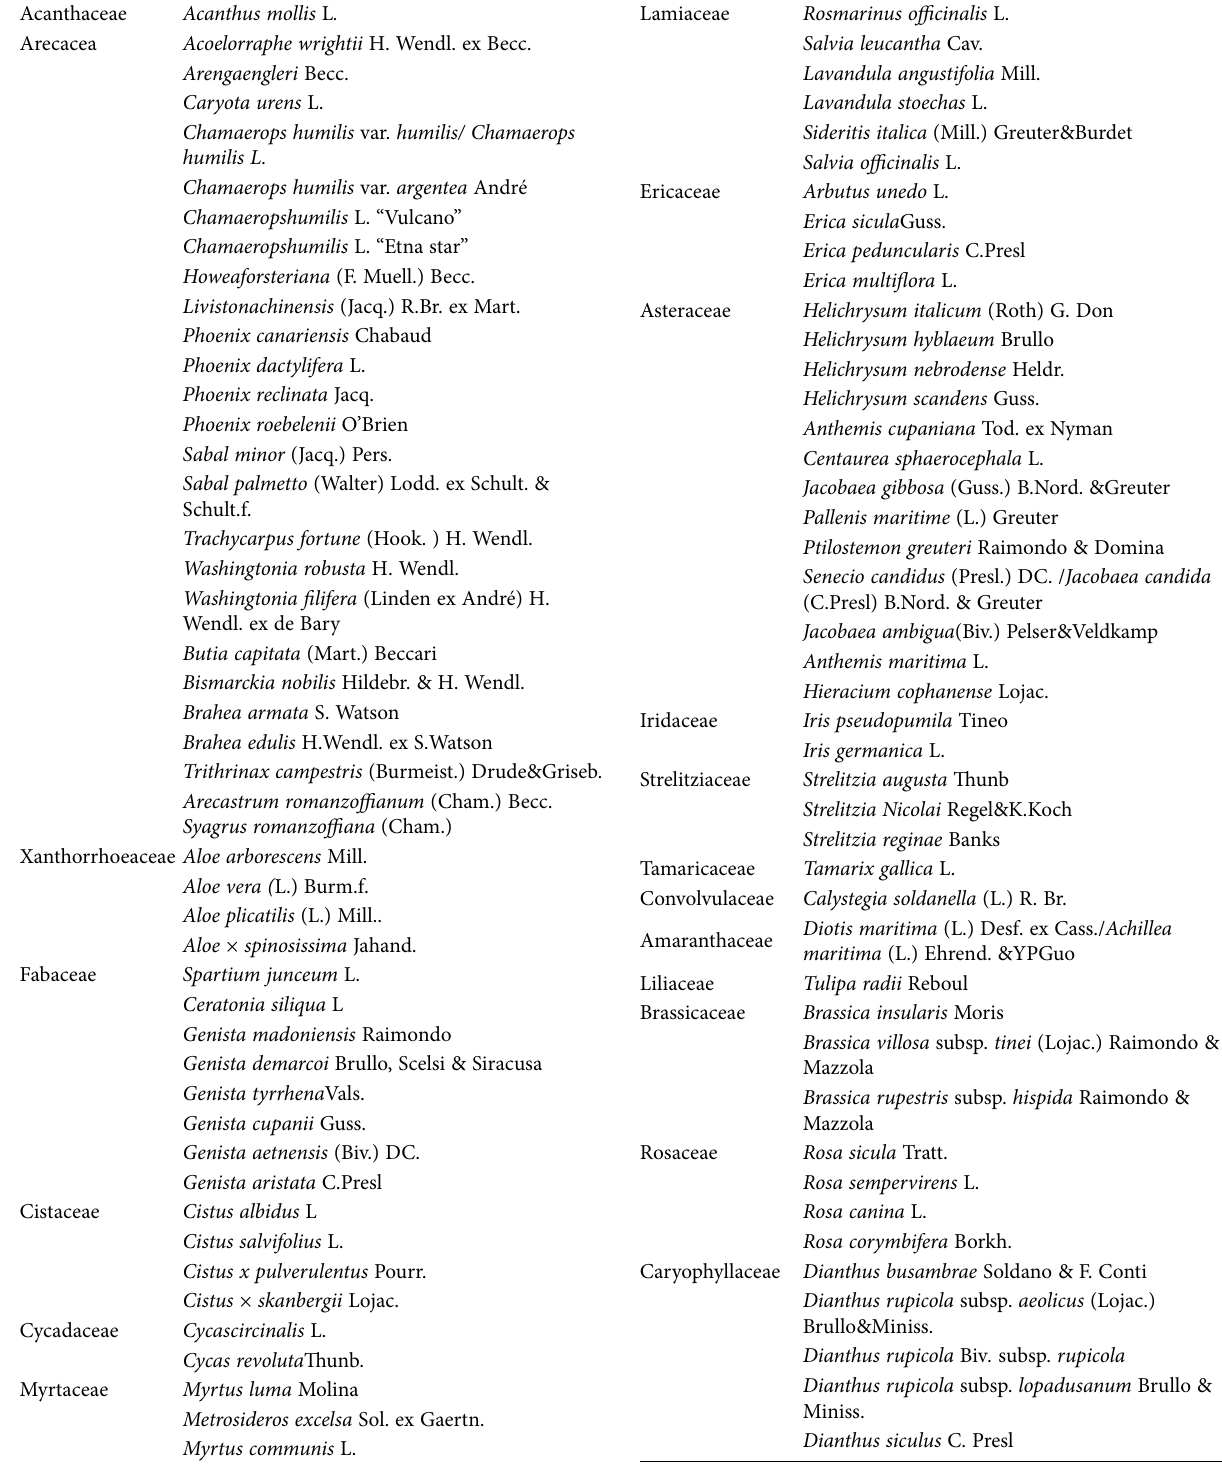
Table 1. Species selected for molecular investigations.